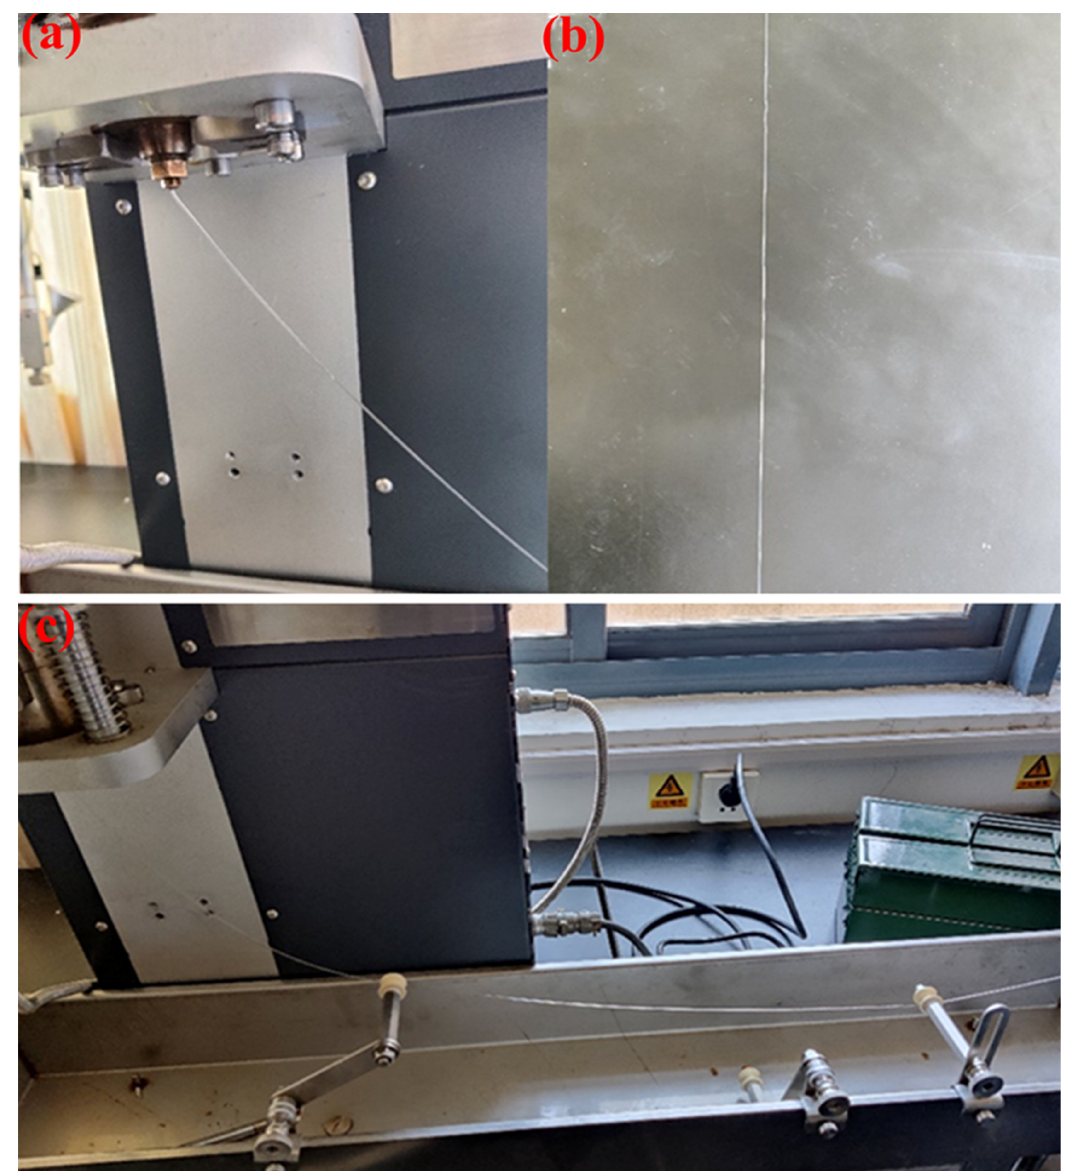
Figure 2. Equipment for melt spinning and drawing: ( a ) nozzle of melt spinning machine, ( b ) YAG ceramic fiber cooling in air, ( c ) drawing mechanism and forming process.